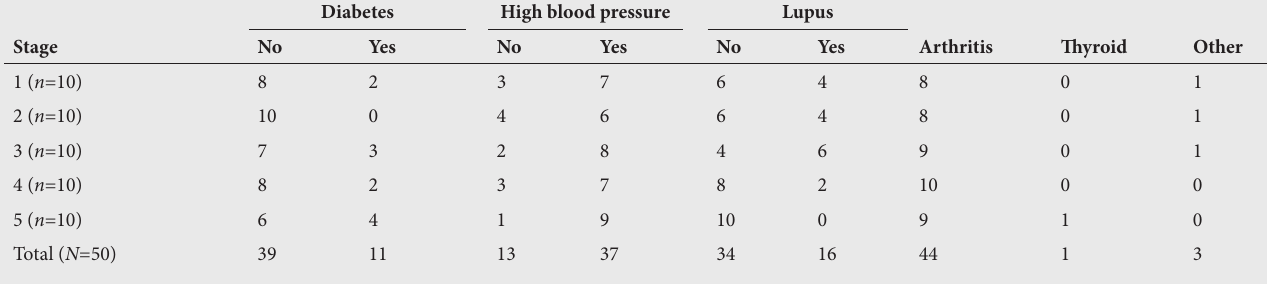
Table 8. Cross tabulation of the various concomitant